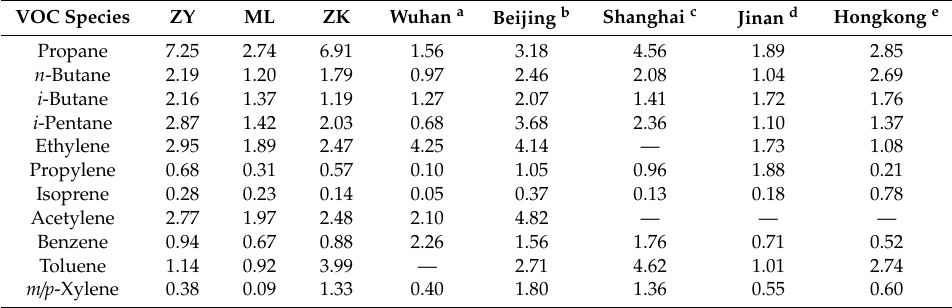
Table 2. The 10 most abundant species (ppbv) measured in Wuhan and other cities. VOC Species ZY